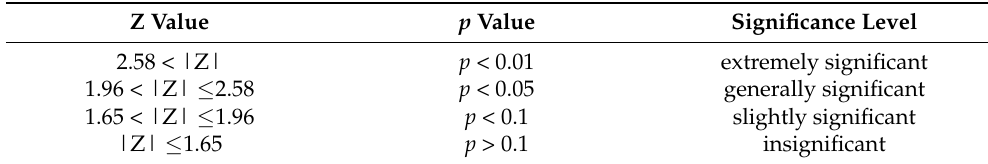
Table 1. Relationship between statistic Z and significance